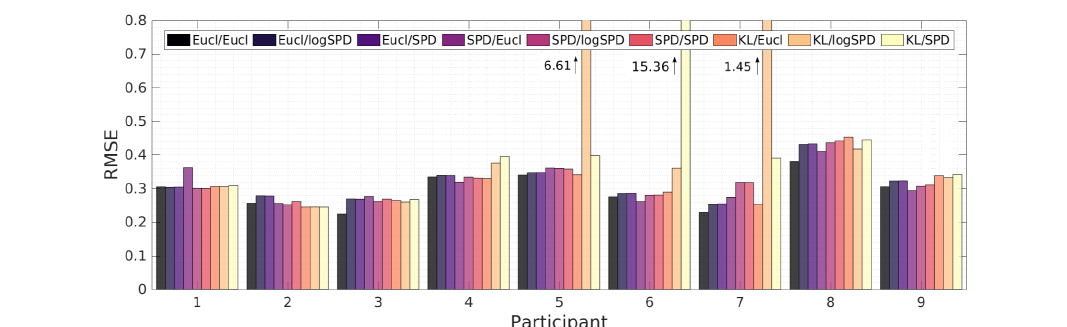
Figure A5. Comparison of the root-mean-square error (RMSE) between Gaussian process regression (GPR) using different kernel distances to combine surface electromyography (sEMG) and tactile myography (TMG) as input, for each